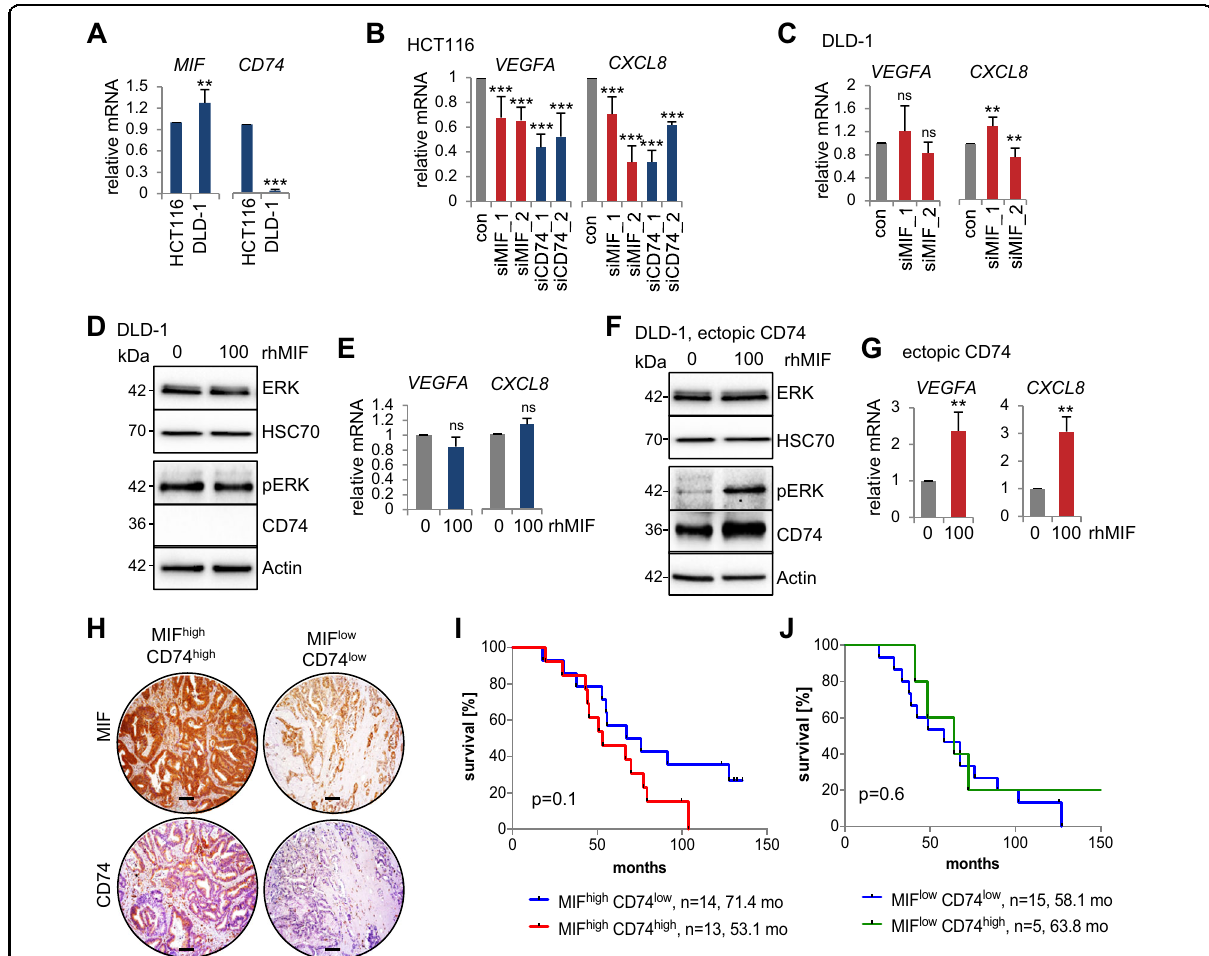
Fig. 5 The CD74-MIF receptor interaction facilitates the expression of angiogenic factors in CRC cells. A qRT-PCR analysis of the relative mRNA levels of MIF and CD74 in HCT116 and DLD-1 CRC cells. Normalized to those of RPLP0 . Means ± SD of 2 biological replicates with 3 technical replicates each. B , C Expression analysis of the indicated angiogenic genes in HCT116 ( B ) or DLD-1 ( C ) cells after siRNA-mediated knockdown of MIF or CD74 for 72 h; a scrambled siRNA served as the control ( ‘ con ’ ). qRT-PCR were normalized to HPRT1 or RPLP0 , respectively. Means ± SD of ≥ 3 technical replicates from two biological replicates. D , F Angiogenic pathway analysis in CD74-de fi cient DLD-1 cells. 48 h after DLD-1 cells were transfected with an empty control ( D ) or CD74 overexpression plasmid ( F ), they were treated with 100 ng/mL recombinant human MIF (rhMIF) for 24 h. Immunoblots of CD74, pERK, and total ERK. Actin and Hsc70, loading controls. E , G Angiogenic marker expression ( VEGFA , CXCL8 ). DLD-1 cells were treated as described in ( D , F ) followed by qRT-PCR. Expression of the indicated genes was normalized to that of RPLP0 . Means ± SD of ≥ 3 technical replicates. H Representative images of serial sections from two human CRC patients stained for MIF and CD74 with different stabilization of MIF (MIF high : stabilized, MIF low : unstabilized) and expression levels of CD74 (CD74 high , CD74 low ). Scale bars, 200 µm. I , J Correlation between patients with stabilized MIF (MIF high ) and CD74 levels (CD74 high , CD74 low ) ( I ) and patients with unstabilized MIF (MIF low ) and CD74 levels (CD74 high , CD74 low ) ( J ) on overall survival of patients. Log-rank (Mantel-Cox) test for comparison of indicated groups. A , B , C , E , G p values were calculated with Student ’ s t tests for comparison of indicated groups; ns = not signi fi cant, * p ≤ 0.05, ** p ≤ 0.01, *** p ≤